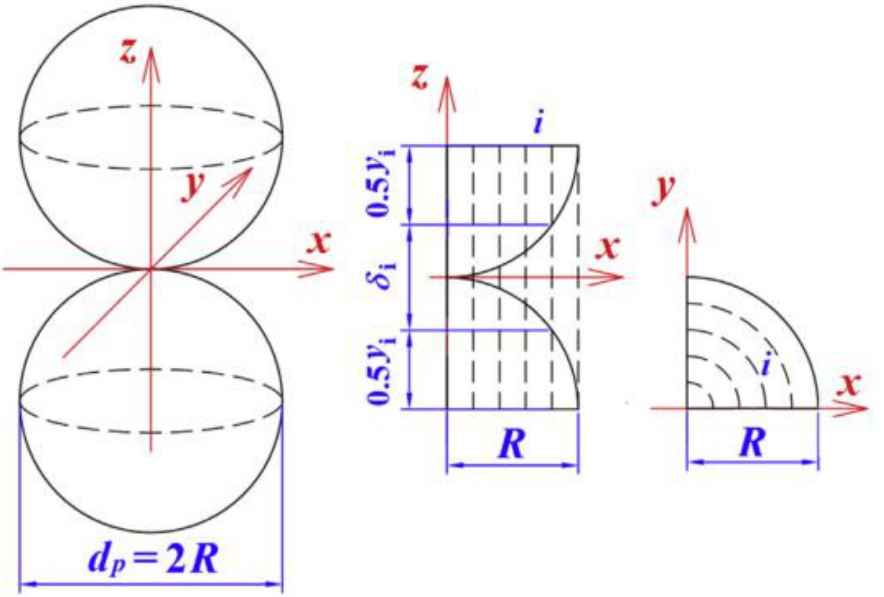
Figure 9. Gas-solid coupling thermal conductivity model established by Swimm et al. [52] ( R is the radius of the particle).